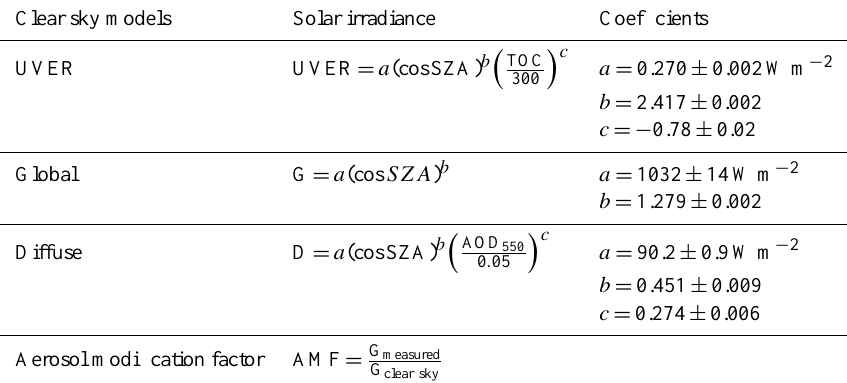
Table 1. UVER, global and diffuse solar horizontal irradiance calibrated models under cloudless conditions, calibration coefficients and their expanded uncertainty, during the period May to October 2012 at Marsaxlokk, Malta.